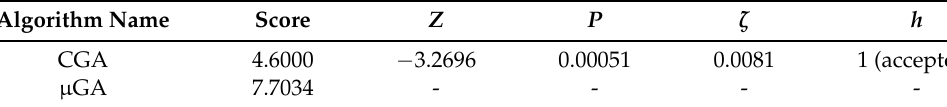
Table 10. Holm–Bonferroni statistical test results.